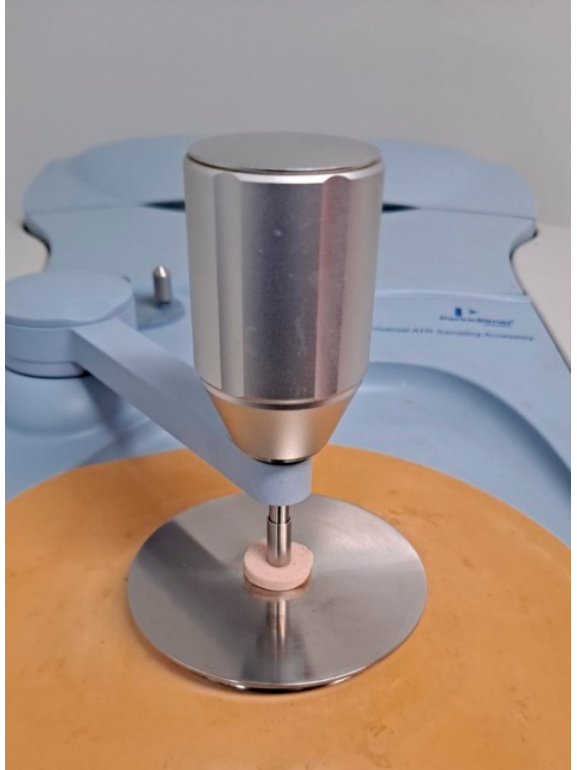
Figure 5. Analysis of frankfurters reformulated with structured lipids based on polyphenol-EGs as animal fat replacers using FT-IR with an ATR device.